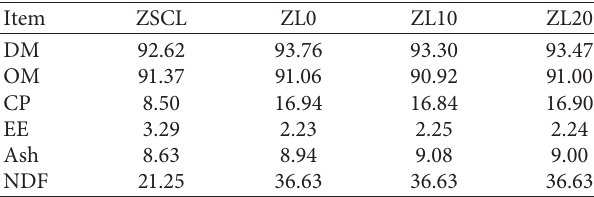
Table 1: Chemical composition of Ziziphus spina-christi leaves and differently tested diet (% on DM